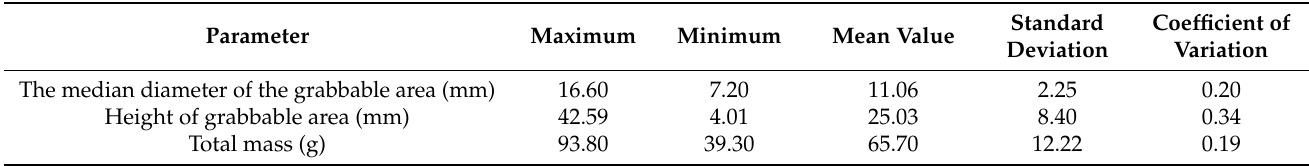
Table 1. Measurement results of grasping related parameters of Lvbao Chinese kale.